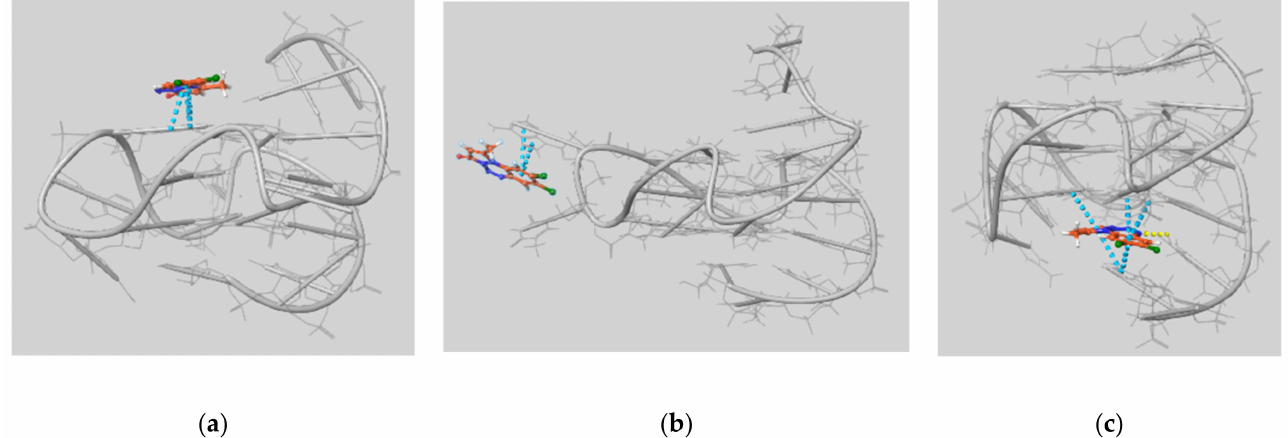
Figure 10. Different modes of π - π (light blue dashed lines) and H-bond (yellow dashed lines) interactions of 8,9-di-Cl with c-myc at 500 K, observed during the migration of the ligand from one docking site to another on the opposite side of the GQ: ( a ) frame at 40 ns: π - π interactions with the guanine 13; ( b ) frame at 45 ns: π - π interactions with adenine 12 belonging to the second loop; ( c ) frame at 50 ns: π - π interactions with guanine 6 and 10 and adenine 21, h-bonding with thymine 20.